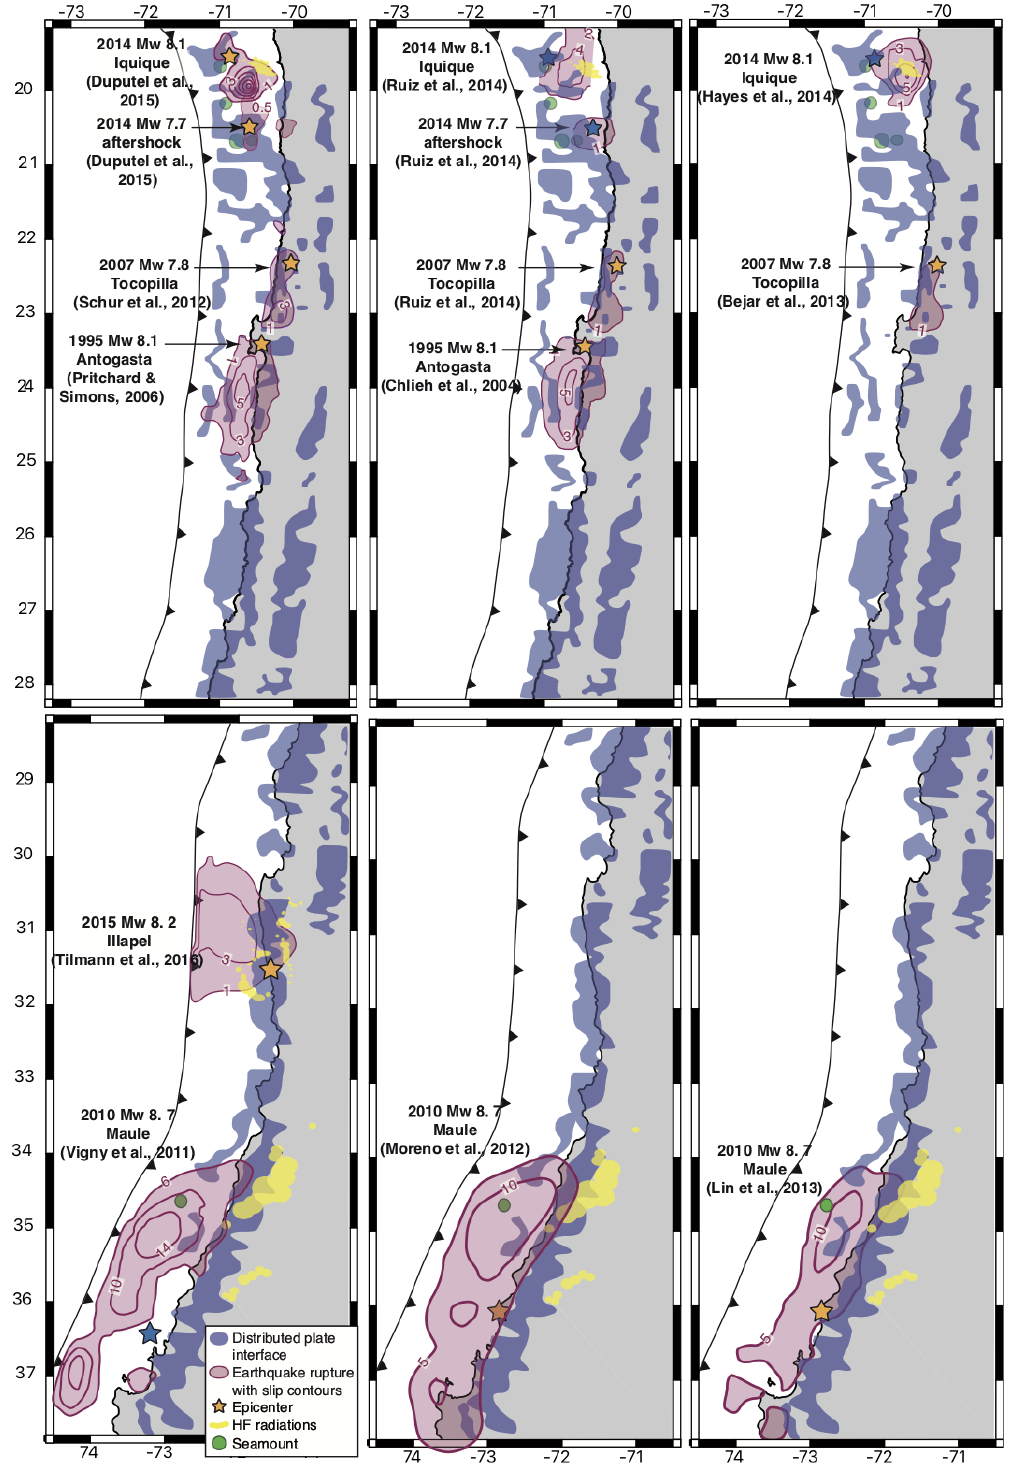
Figure 6. Areas prone to distributed deformation along the plate interface compared to various published co-seismic slip models (Duputel et al., 2015; Schurr et al., 2012; Pritchard and Simons, 2006; Tilmann et al., 2016; Vigny et al., 2011; Ruiz et al., 2014b; Chlieh et al., 2004; Moreno et al., 2010; Hayes et al., 2014; Béjar-Pizarro et al., 2013; Lin et al., 2013). Orange stars: GCMT solutions, blue stars: CSN solution.